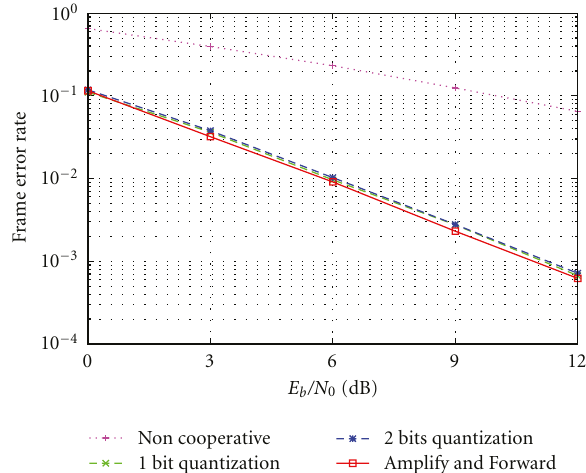
Figure 3: Frame Error Rate of a turbo-coded Quantize and Forward system with known channel parameters using BPSK mapping and 12 decoder